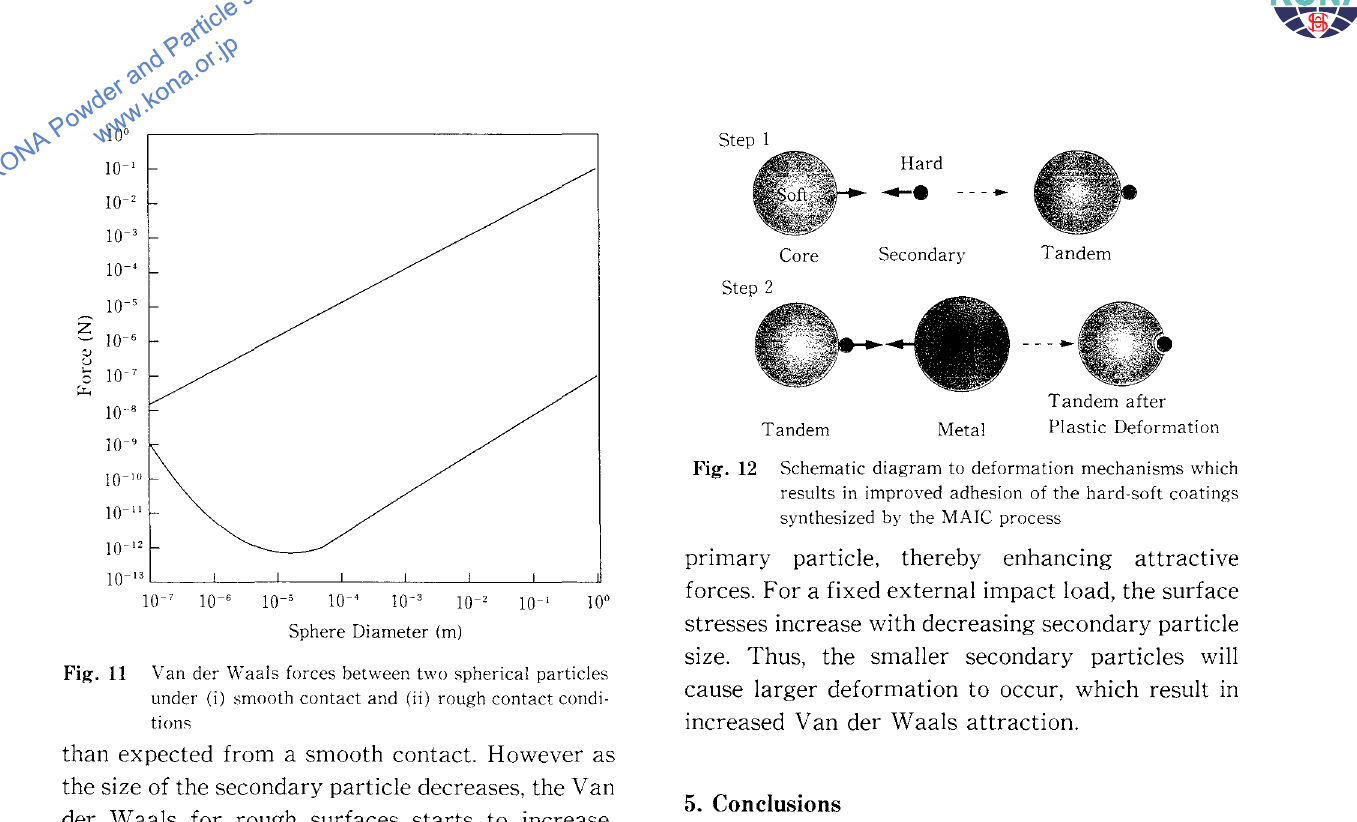
Fig. 12 Schematic diagram to deformation mechanisms which results in improved adhesion of the hard-soft coatings